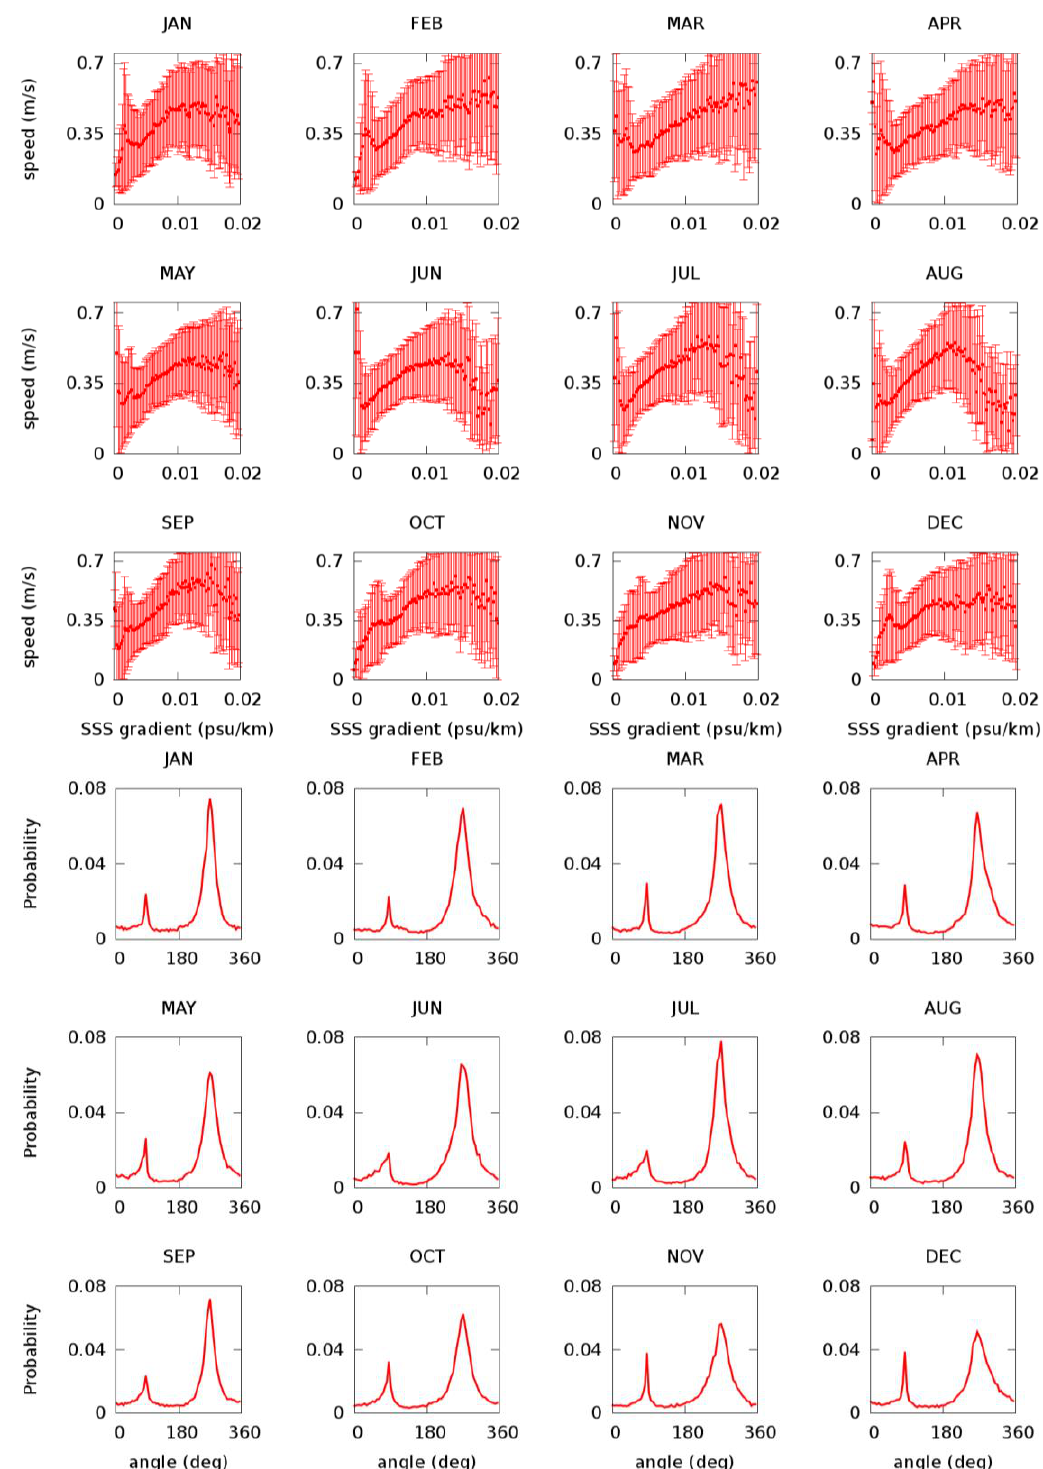
Figure 6. A s in Figure 5, but for the BMC. Figure 6. As in Figure 5, but for the